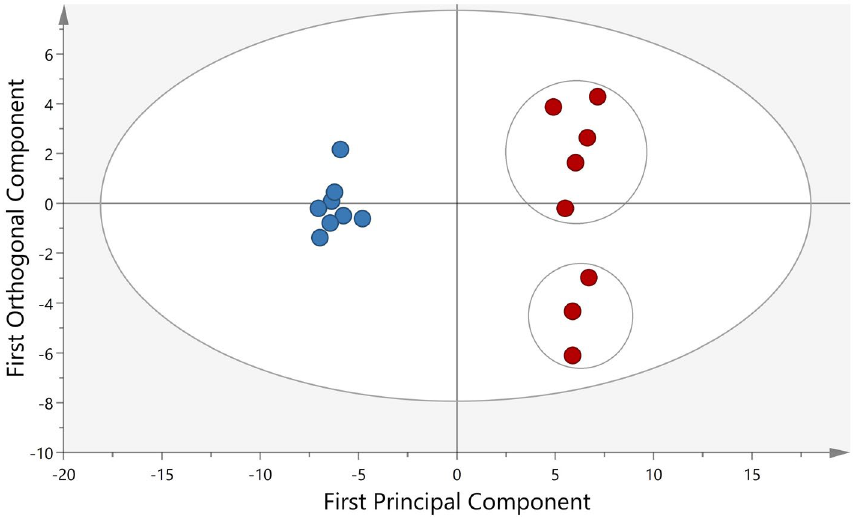
Figure 4. Orthogonal partial least square discriminant analysis (OPLS-DA) of the proteome before and after glucose provocation. The score plot shows the separation in protein expression between baseline (blue) and after glucose provocation (red). R 2 = 0.99, Q 2 = 0.91, CV-ANOVA p value = 1.6E −10 . The x-axis represents intergroup differences while the Y-axis represents intragroup differences.